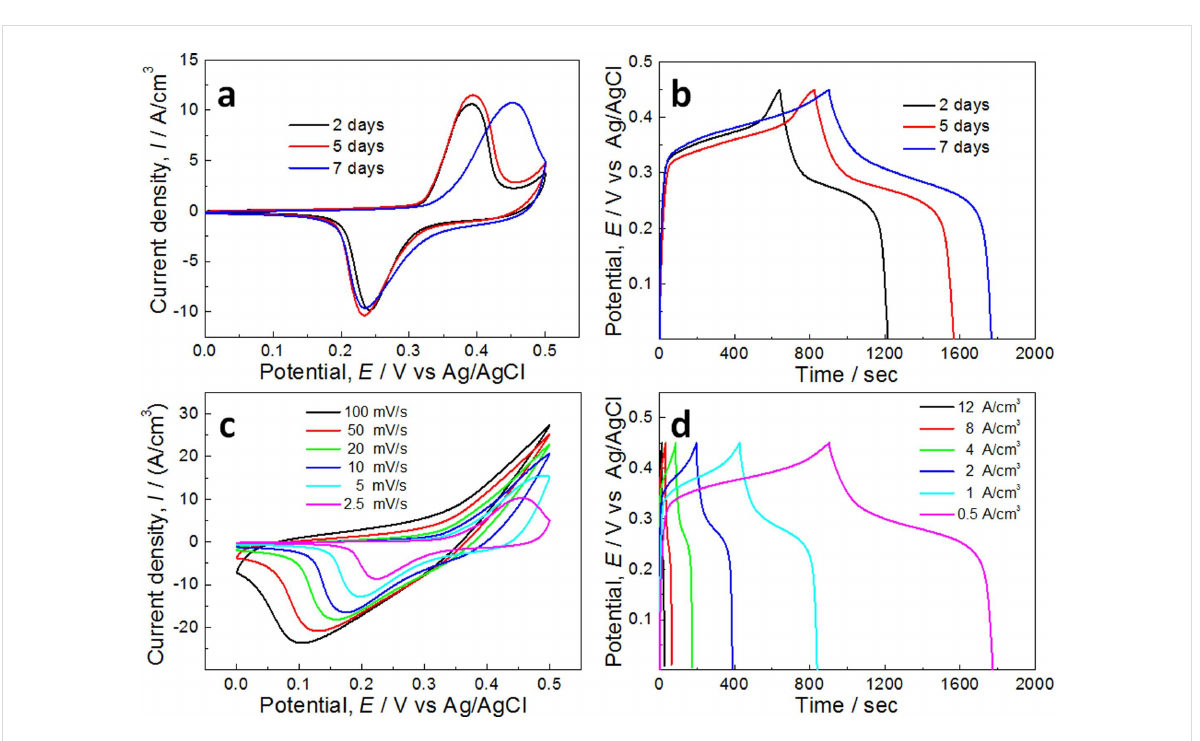
Figure 5: (a) CV curves of the Ni(OH) 2 /Ni-NF/MG-2, Ni(OH) 2 /Ni-NF/MG-5, Ni(OH) 2 /Ni-NF/MG-7 electrodes at a scan rate of 0.5 mV/s in 1 M KOH solution; (b) GCD curves of the Ni(OH) 2 /Ni-NF/MG-2, Ni(OH) 2 /Ni-NF/MG-5, Ni(OH) 2 /NiNF/MG-7 at a current density of 0.5 A/cm 3 ; (c) CV curves of the Ni(OH) 2 /Ni-NF/MG-5 at different scan rates from 2.5 to 100 mV/s; (d) GCD curves of the Ni(OH) 2 /Ni-NF/MG-5 at different current densities from 0.5 to 12 A/cm 3